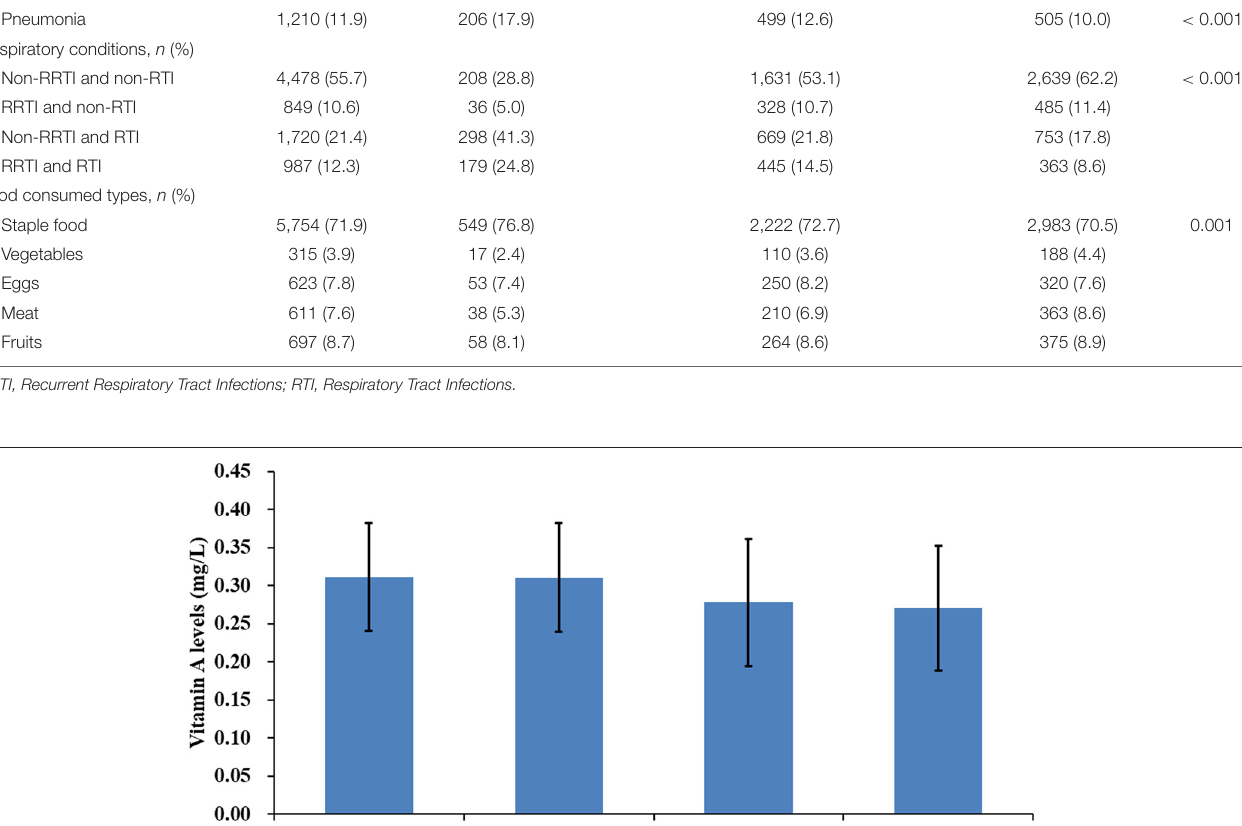
Frontiers in Pediatrics |